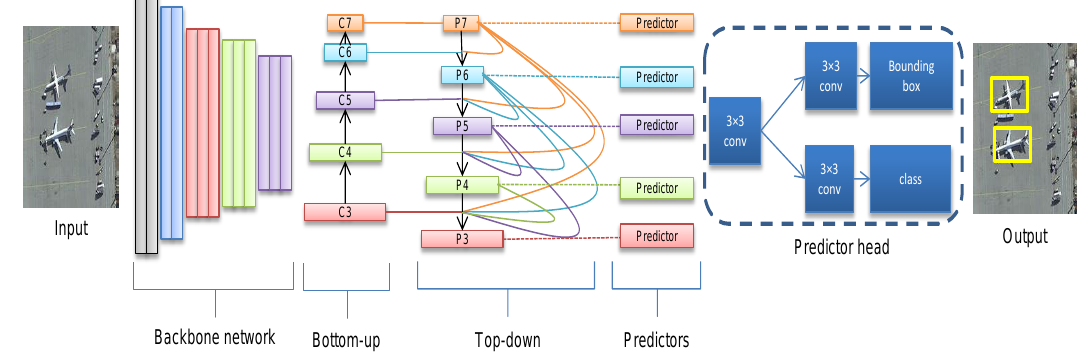
Figure 2. The overall architecture of the proposed